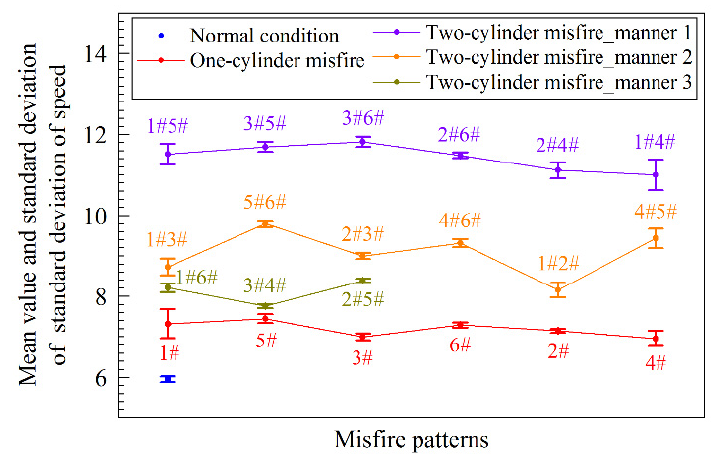
Figure 6. Mean values and standard deviations of the standard deviation of crankshaft speed under 800 r/min and no-load condition with different misfire patterns. Manner 1 represents misfire of two consecutive cylinders in firing order; manner 2 represents misfire of two cylinders with one-cylinder interval; manner 3 represents misfire of two cylinders with two-cylinder interval.